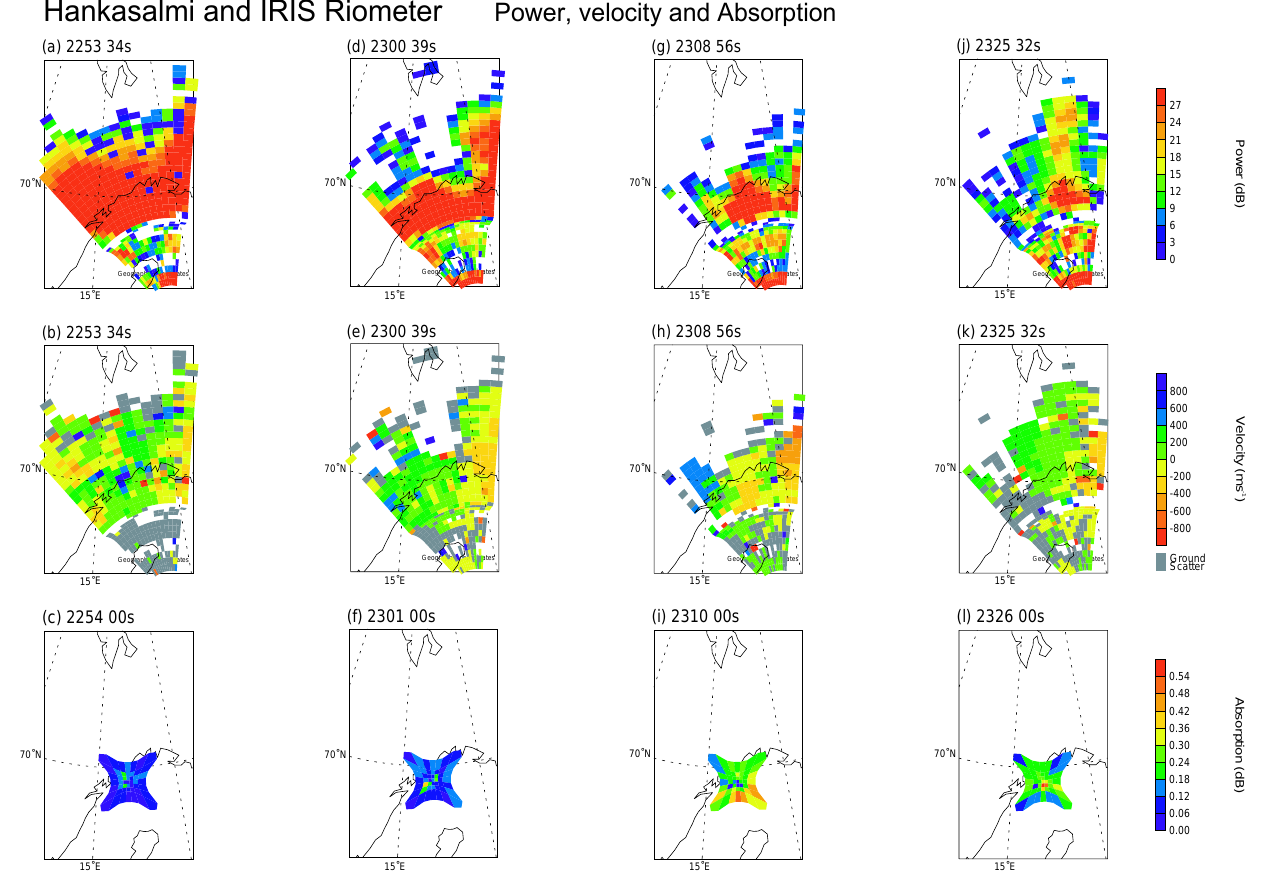
Fig. 3. Spatial distribution, in geographic coordinates, of the Hankasalmi backscatter power (top row), Hankasalmi line-of-sight velocity (middle row) and IRIS absorption (bottom row) during the substorm. The first column presents a time prior to the radar signal loss, the middle two columns present data during the signal loss period, and the final column shows the data after the radar signal has recovered.